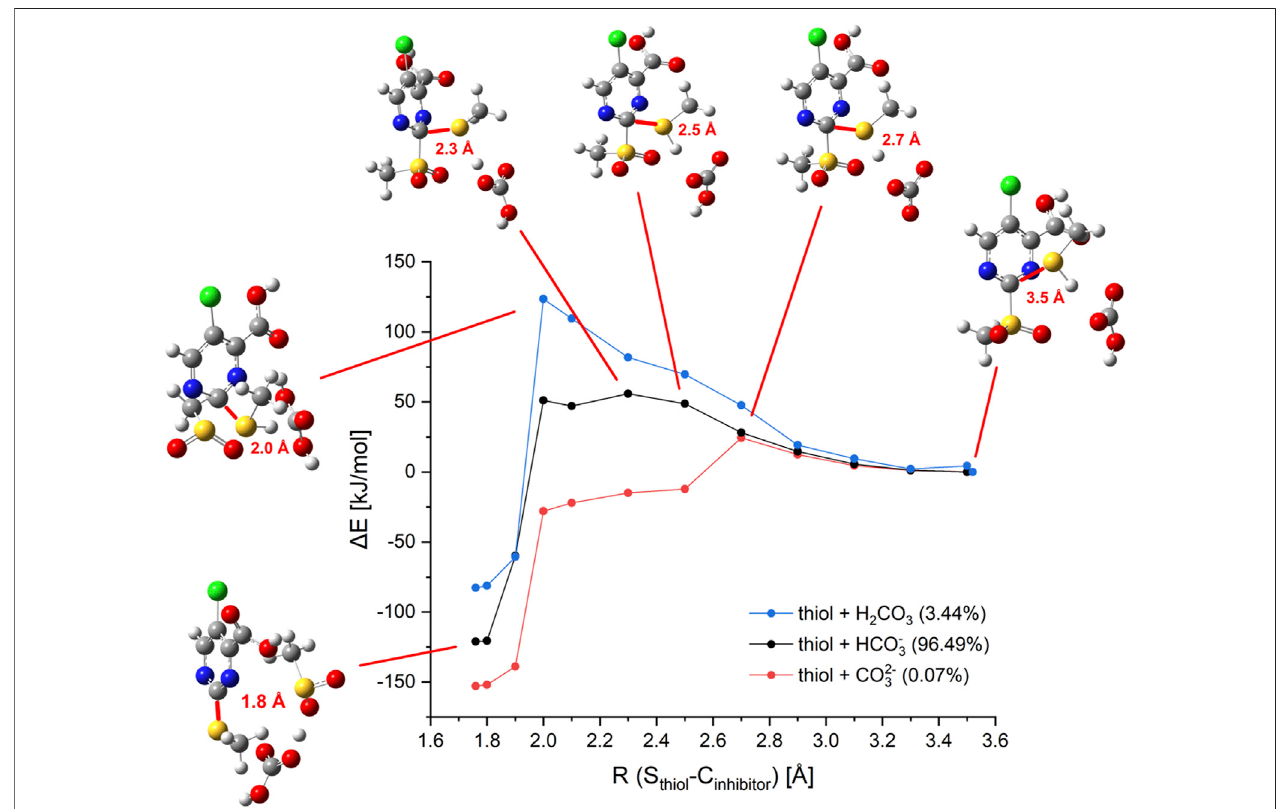
FIGURE9| Computedreactionpaths mediatedbybicarbonate buffer.Energypro fi leofthecalculatedmodelreaction ofinhibitor 5c withmethanethiol inpresence of bicarbonate buffer species (and distribution of species at pH 7.5). Selected structures are shown in ball and stick representation with the reaction coordinate R (S thiol – C-2 inhibitor ) given in